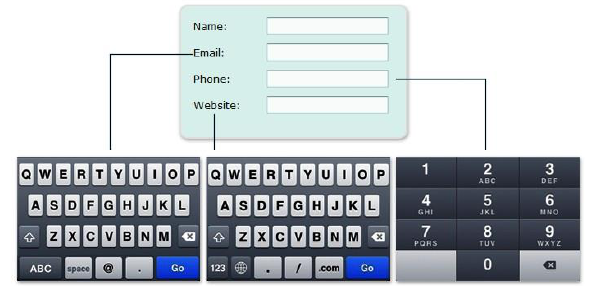
Fig. 7. Automatic change of keyboard layouts depending on a field type in Safari, Apple